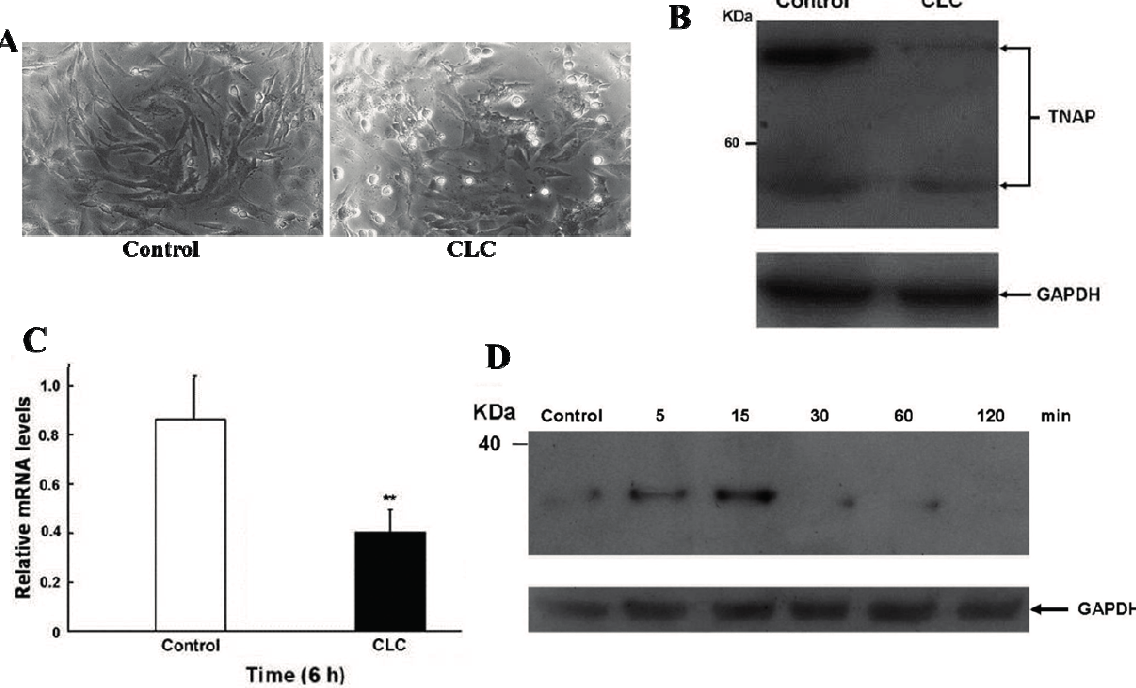
Figure 2. CLC induced morphological changes ( A ), reduced ALP expression ( B , C ) and increased I κ B α phosphorylation ( D ) of dermal papillae cells (DPCs) in vitro . DPCs